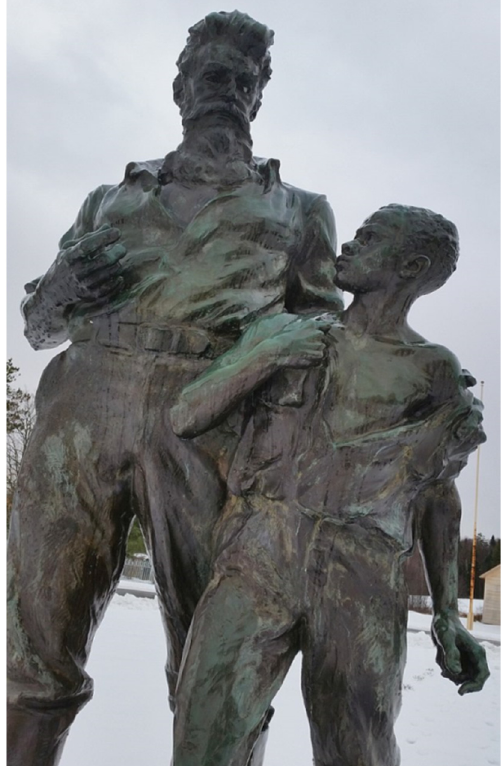
Figure 2. Joseph Pollia, John Brown, John Brown’s Farm State Historic Site, Lake Placid, New York, 1935. https://en.wikipedia.org/wiki/Joseph_Pollia#/media/File:John-Brown-Pollia-1935.jpg (accessed on 5 May